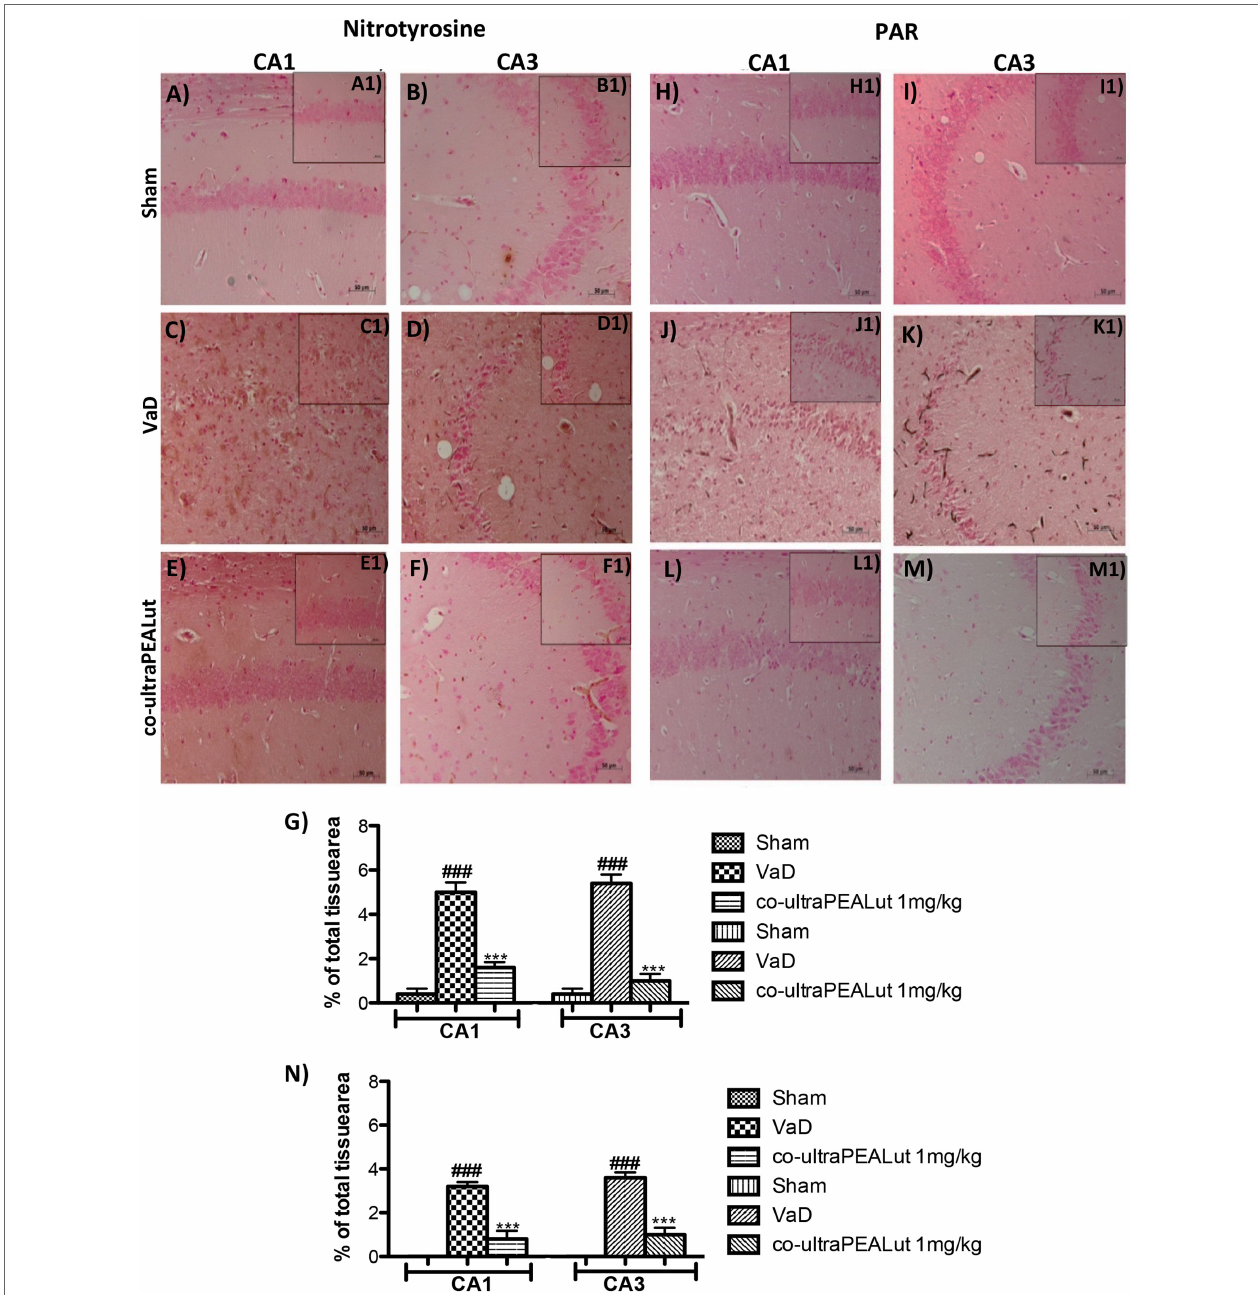
FigUre 7 | effects of co-ultraPealut treatment on nitrotyrosine and Par formation in VaD . Brain sections from Sham mice did not stain for nitrotyrosine (a,a1,B,B1,g) and for PAR (h,h1,i,i1,n) , sections from VaD mice exhibited positive immunostaining for nitrotyrosine (c,c1,D,D1,g) and PAR formation (J,J1,K,K1,n) . Treatment with co-ultraPEALut reduced the degree of positive immunostaining for nitrotyrosine (e,e1,F,F1,g) and for PAR formation (l,l1,M,M1,n) in hippocampal CA1 and CA3 regions. (g) *** p < 0.001 vs. Sham; ### p < 0.001 vs. VaD; (n) *** p < 0.001 vs. Sham; ### p < 0.001 vs. VaD, as determined by one-way ANOVA followed by Bonferroni post hoc